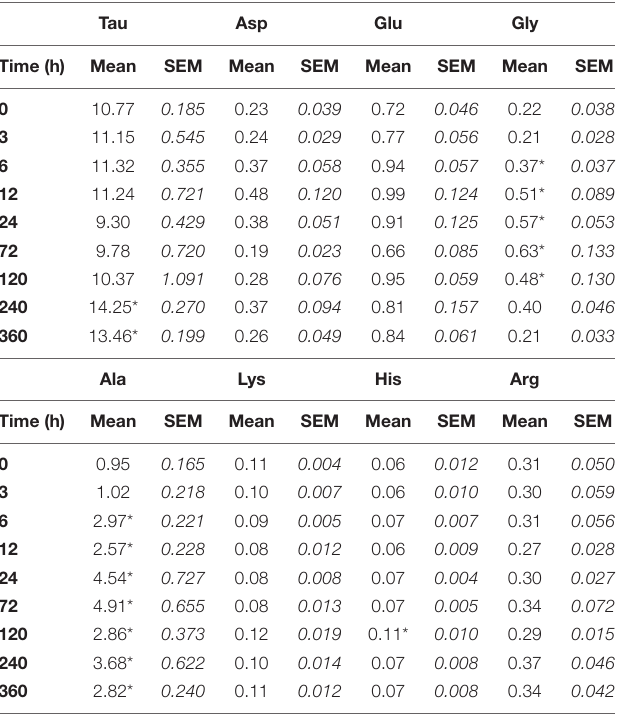
TABLE 1 | Time-course changes in free amino acid (FAA) content of the gills of Asian hard clams transferred from brackish water (20